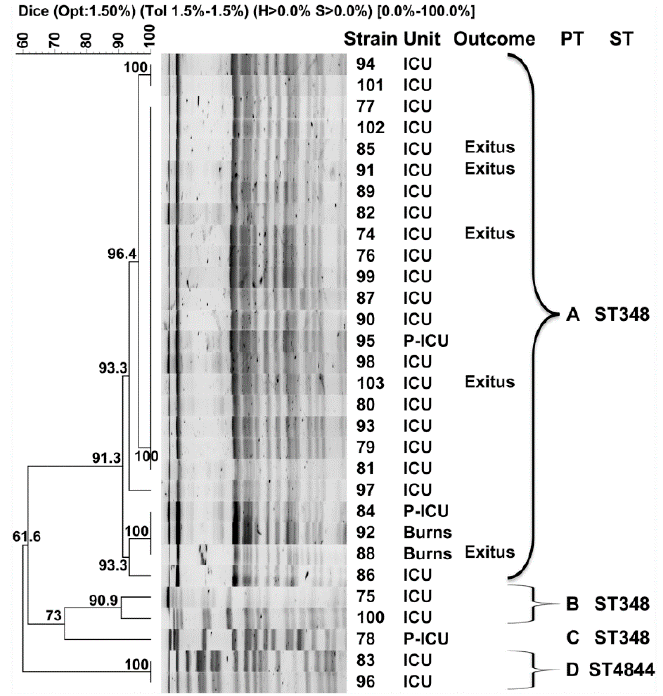
Figure 1. Pulsed-field gel electrophoresis (PFGE) dendrogram of New Delhi metallo- β -lactamase (NDM)-producing K. pneumoniae isolates from Guillermo Almenara Irigoyen Hospital in Lima. PT: pulsotype. ST: sequence type. ICU: intensive care unit. P-ICU: pediatric ICU. Braces indicate classification to the corresponding PFGE cluster, or pulsotype. Isolates were included in the same pulsotype if their Dice similarity index was ≥ 85%.